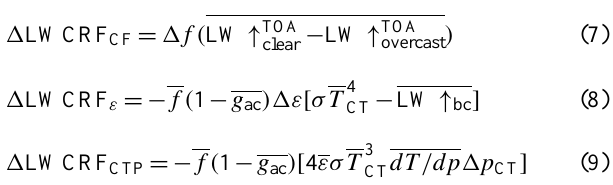
cloud top level and the top of the atmosphere. It is simi- changes in cloud fraction, cloud emissivity, and cloud-top pressure on LWCRF: